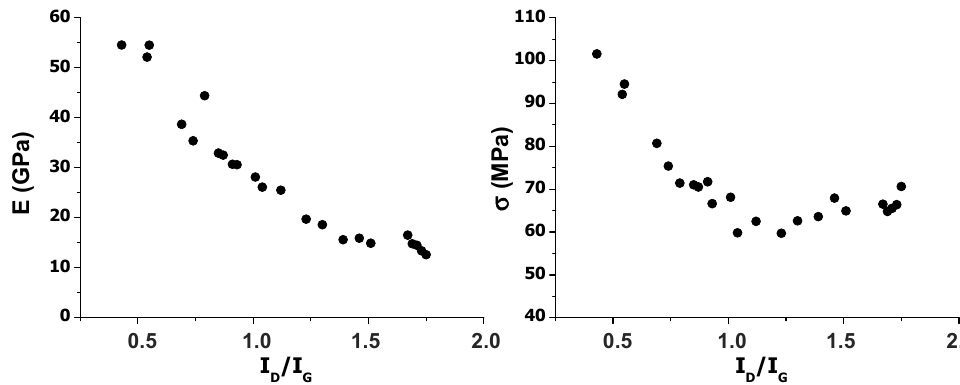
Figure 10. Young’s modulus (E) and tensile strength ( σ ) versus the I D /I G band intensity ratio.